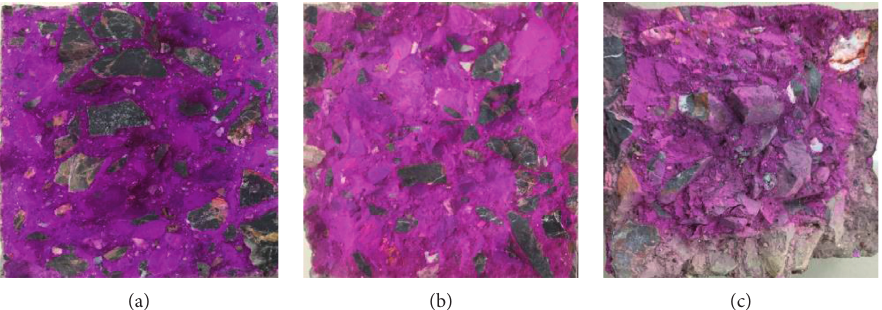
Figure 20: Neutralization test pictures of DSRR-60% after elevated temperature. (a) Room temperature. (b) 300 ° C. (c) 700 ° C.